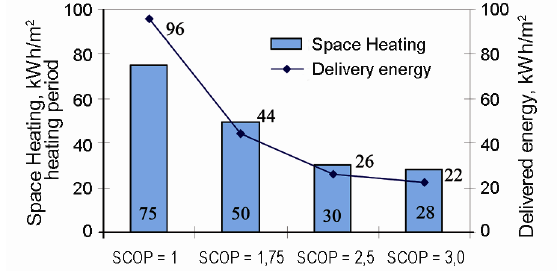
Fig. 11. The change in space heating demand and delivered energy for the different types of